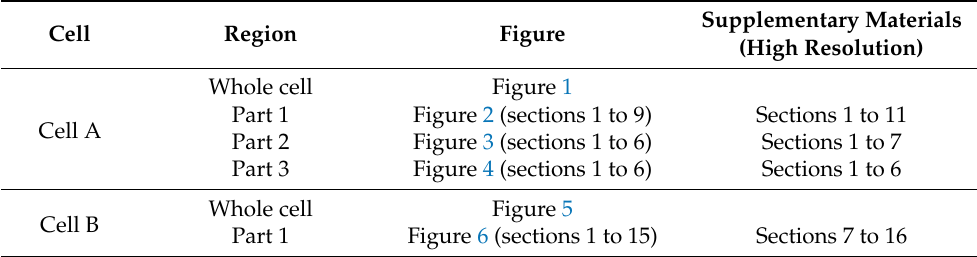
Table 1. List of the different cells, cell regions, and corresponding serial sections analysed in this